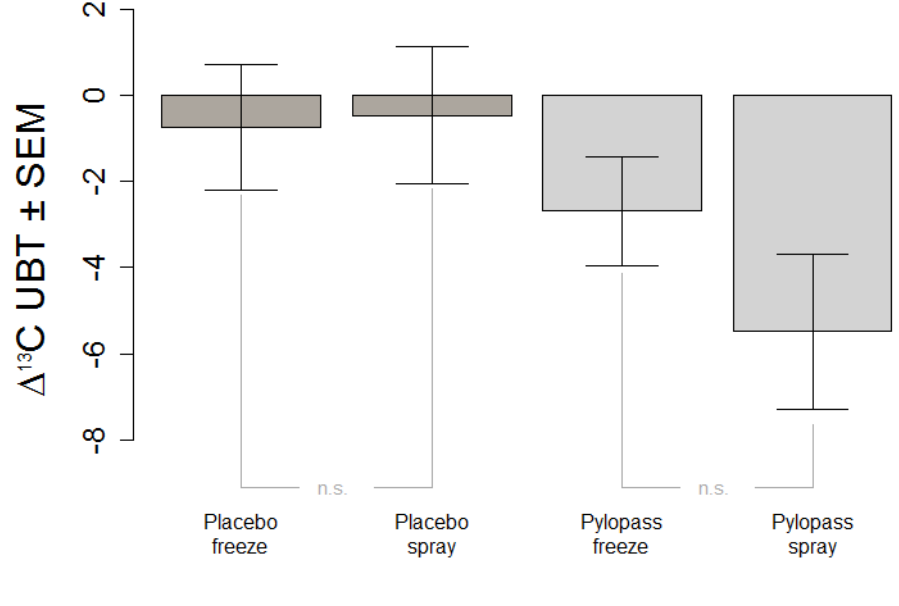
Figure 4. Comparison of freeze-dried and spray-dried L. reuteri supplement in terms of change of 13C UBT after placebo and